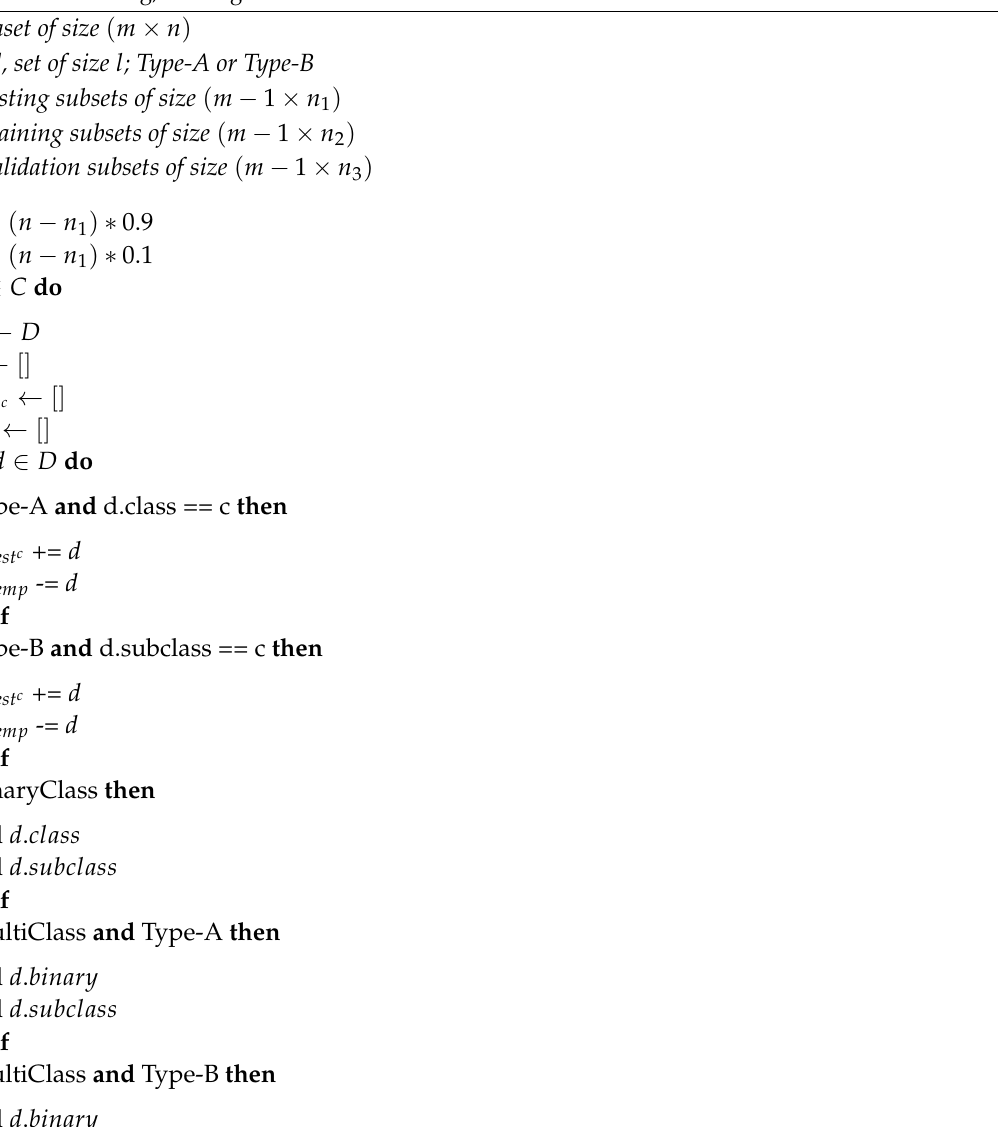
Procedure 1 Generate testing, training and validation sets for unknown